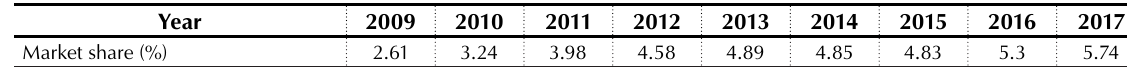
Table 2. The Islamic banking market share